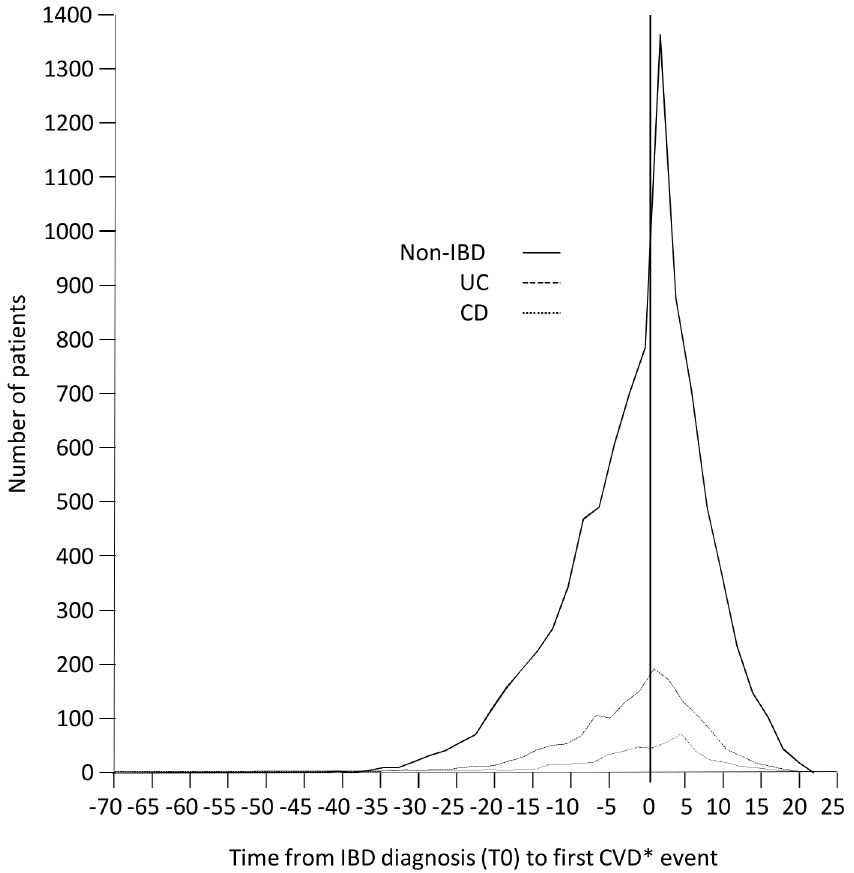
Fig 2. Time from IBD diagnosis (T0) to first IHD event according to IBD type. Total number of patients showing time from IBD diagnosis (T0) to the first cardiovascular event (incorporating IHD, CHD, angina and